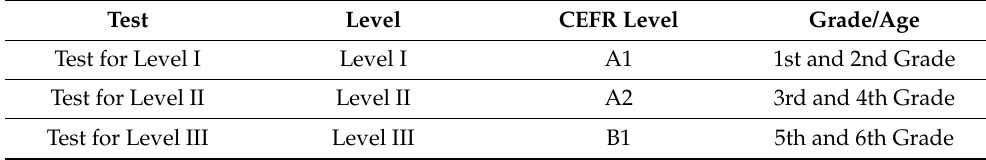
Table 4. Correspondence of tests, ages and language level competence